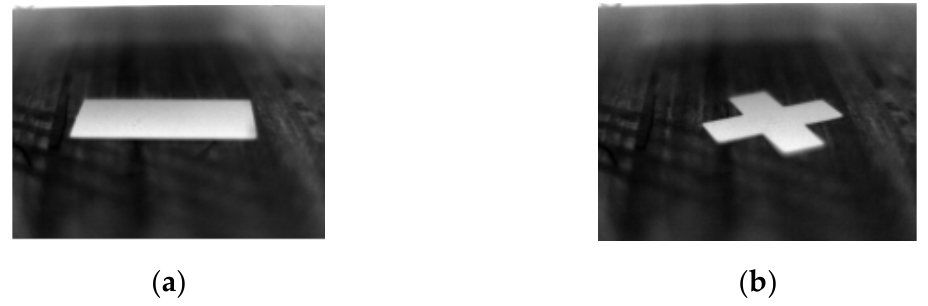
Figure 4. Calibration targets. ( a ) Quadrilateral calibration targets. ( b ) Polygonal calibration targets.